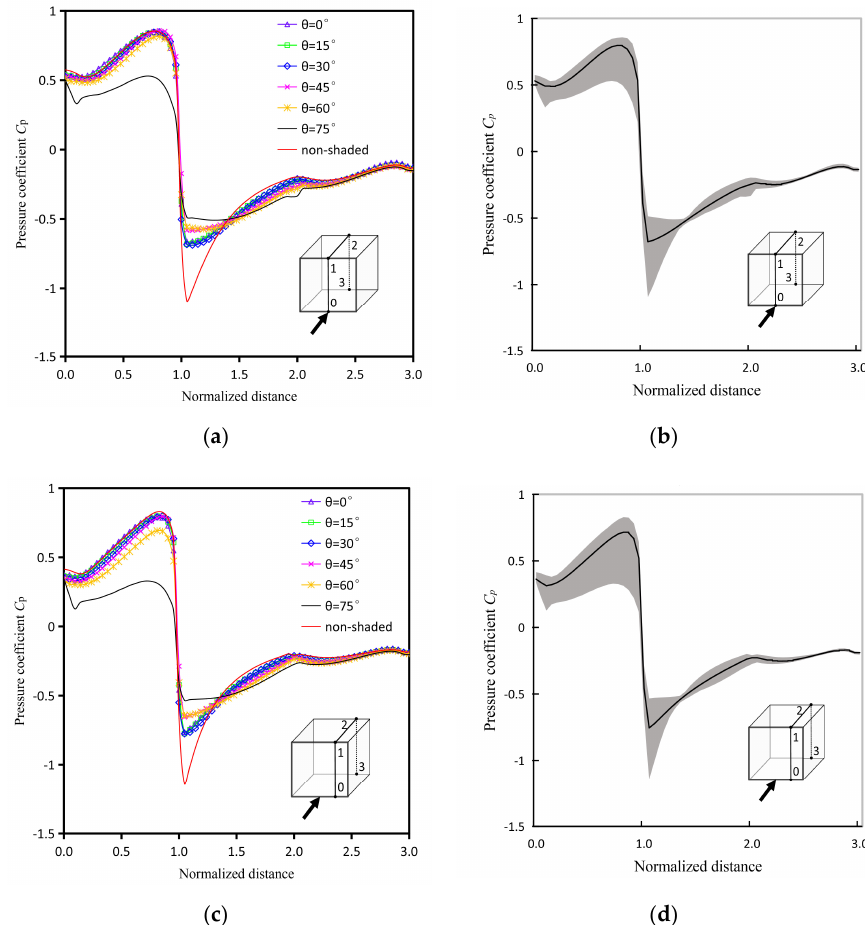
Figure 12. Local range R , local and average value of wind pressure coefficient C p for different shaded conditions on the central lines of different rows along the windward, roof and leeward surfaces. ( a ) Local value along R1 and R7; ( b ) Local range R and average value along R1 and R7; ( c ) Local value along R2 and R6; ( d ) Local range R and average value along R2 and